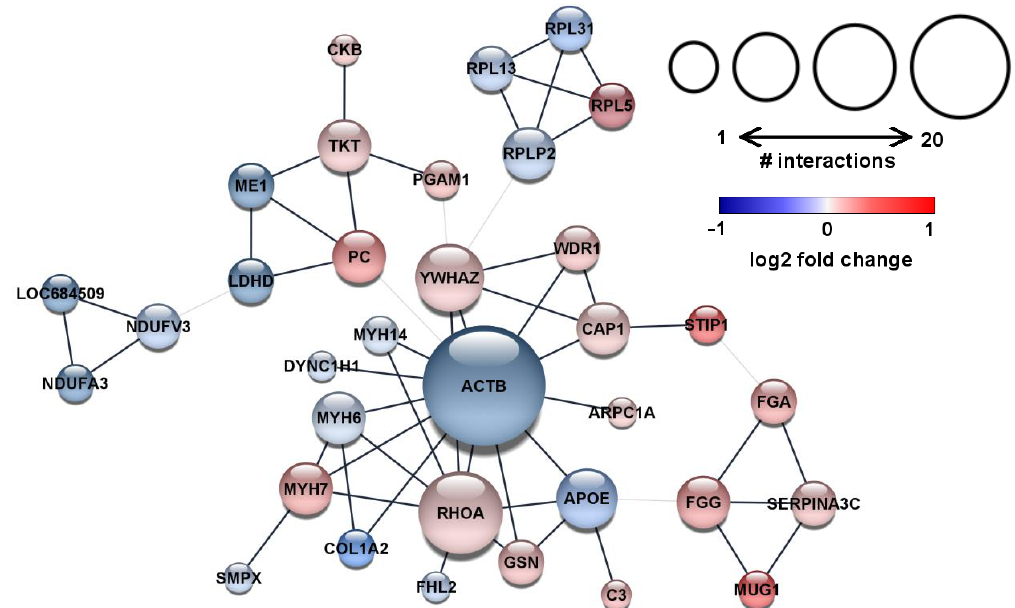
Figure 3. Downregulated beta-actin was established as a prominent hub of the protein interaction network in the hypercholesterolemic myocardium. Functional protein – protein interaction network and subsequent cluster analysis according to Markov Clustering Algorithm using the STRING database and the in-built plugin of Cytoscape. Each node (circle) represents one protein and is labeled according to gene IDs. The node size corresponds with the number of interactions of the respective protein. The color of each node indicates the fold change values (red for upregulated and blue for downregulated expression). Edges (grey lines) represent the interactions between nodes, with their thickness indicating interactions within the clusters (wide edges) or among the proteins in different clusters (narrow edges).